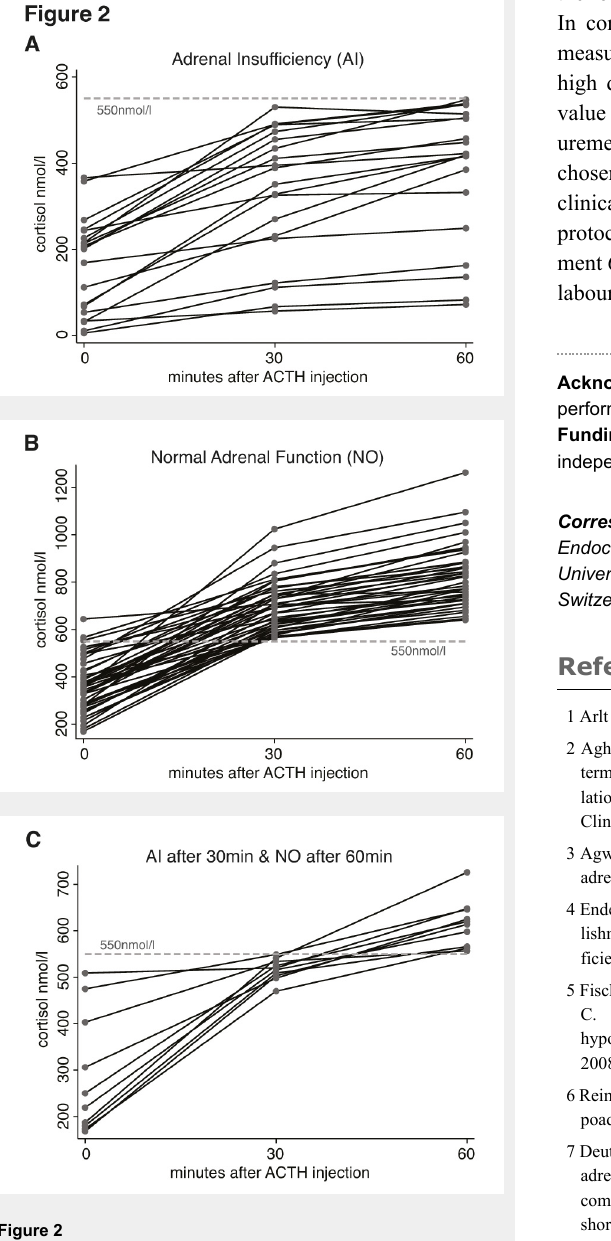
Figure 2 Individual cortisol values at time points 0, 30, and 60 minutes after injection of ACTH; grouped by patients with adrenal insufficiency (fig. 2a), normal adrenal function (fig. 2b) and patients with discrepant adrenal response at 30 and 60 minutes (fig.